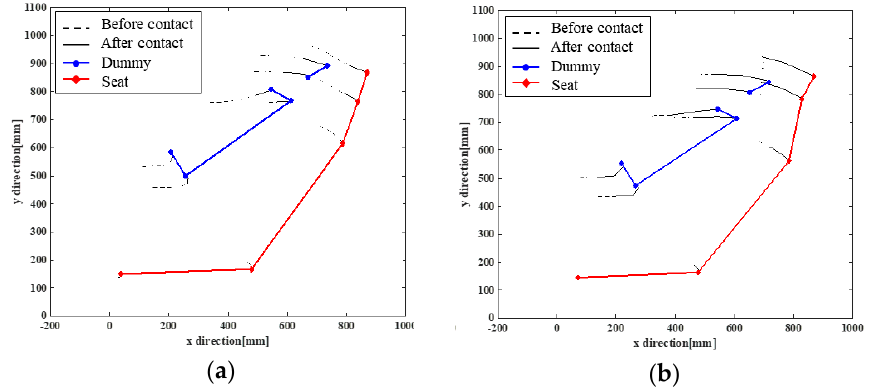
Figure 11. Trajectories of seat and dummy: ( a ) active headrest seat and dummy trajectory; ( b ) proactive headrest seat and dummy trajectory.